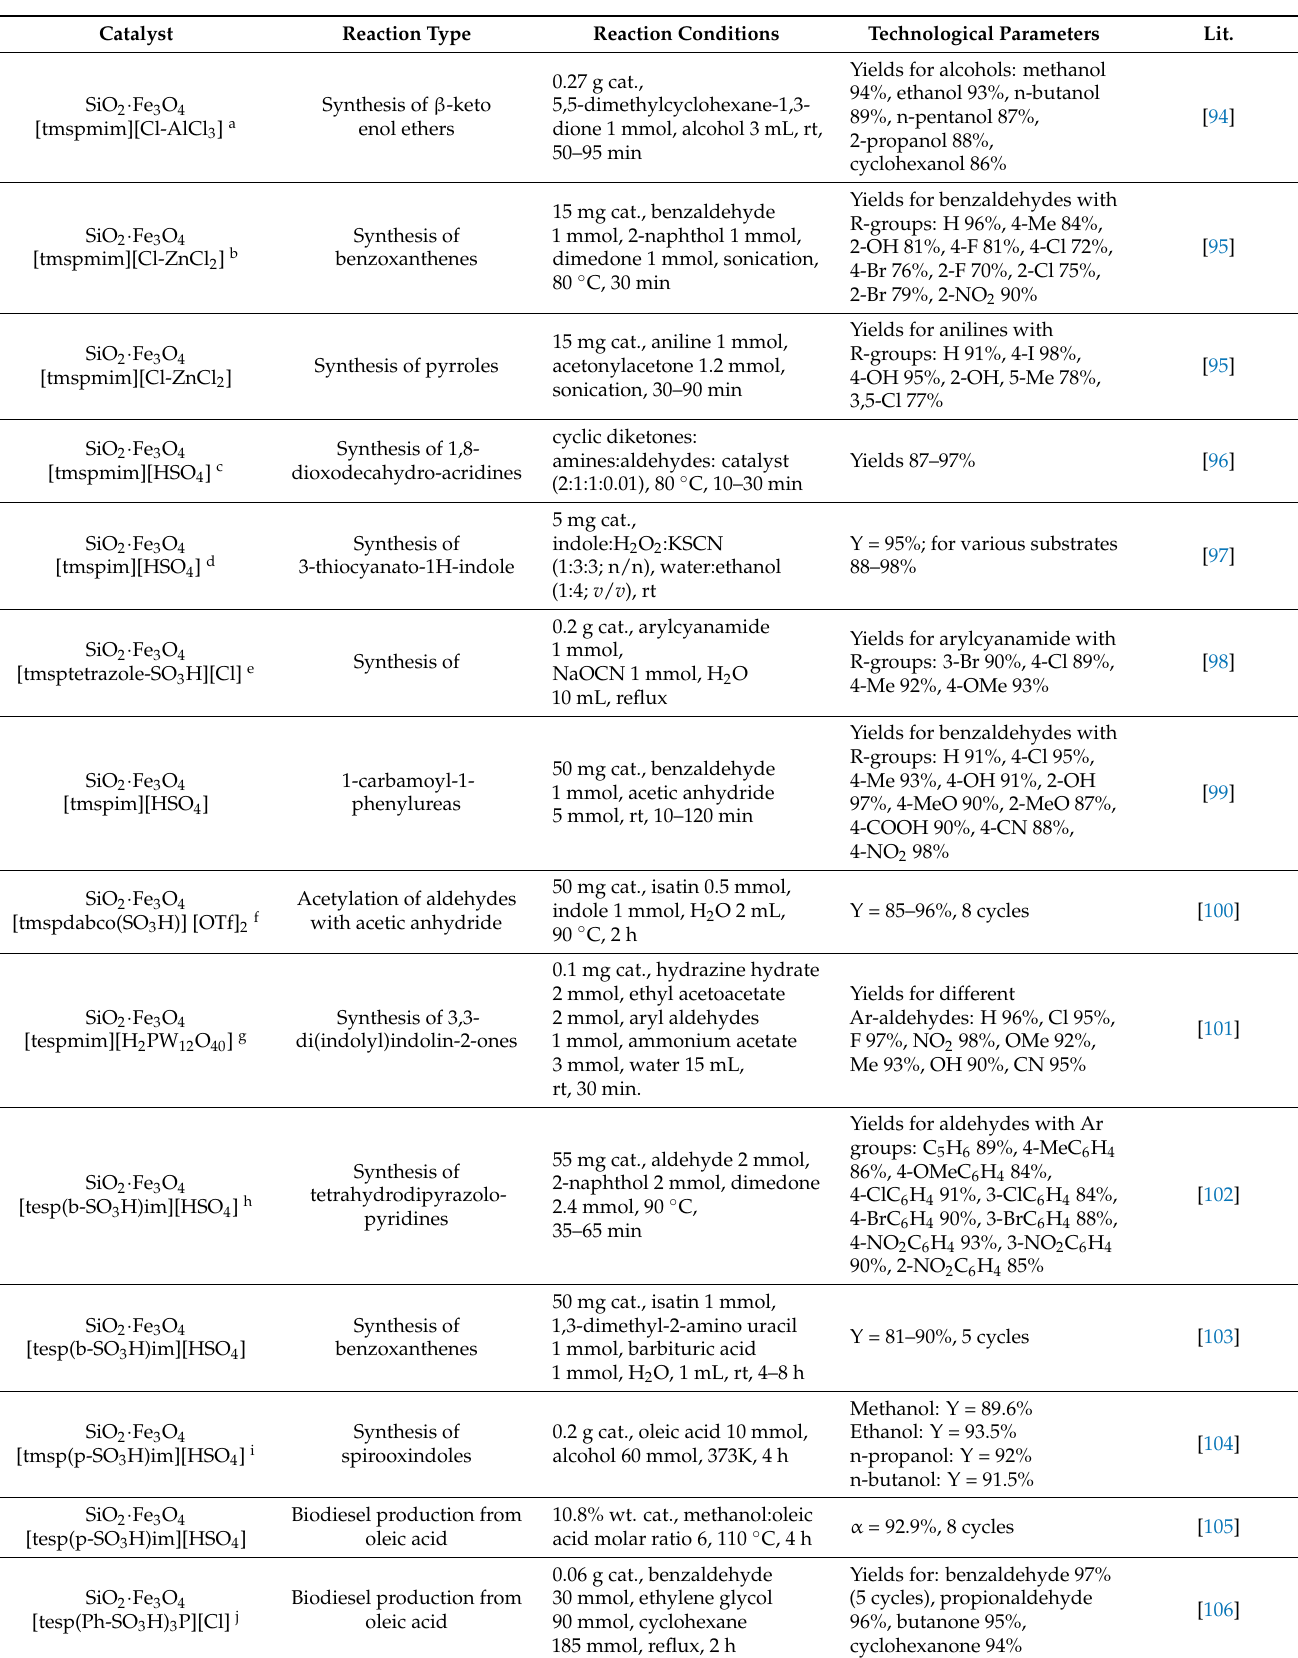
Table 3. Silica-Fe 3 O 4 -based SILLPs in organic